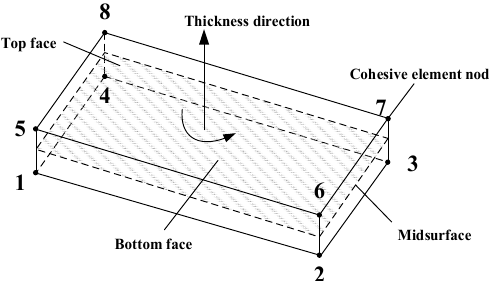
Figure 10. The stress–strain curves of aluminum foam with different densities.